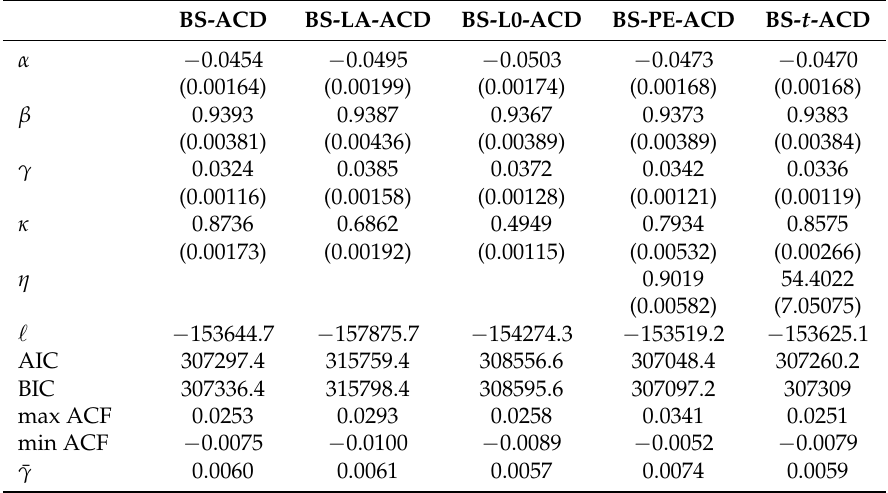
Table 4. Estimation results based on the generalized Birnbaum–Saunders autoregressive conditional duration (GBS-ACD) models for IBM trade durations.